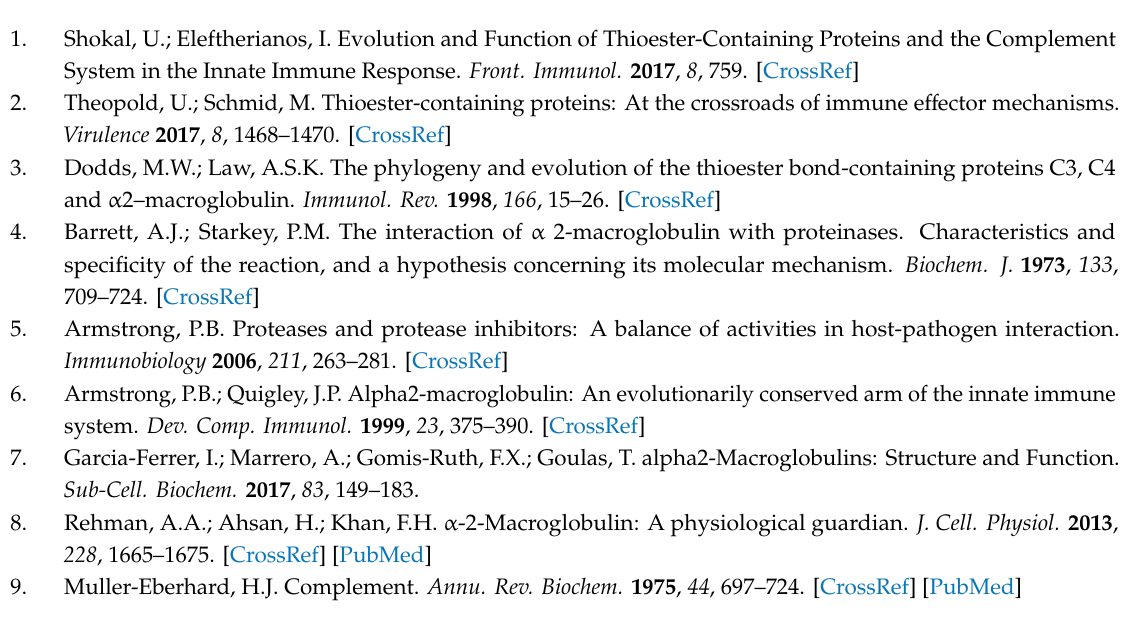
Figure S1: Alignment file of TEP protein sequences used for the phylogenetic analysis; Figure S2: cDNA sequences of the 11 TEP of Biomphalaria glabrata; Figure S3: ClustalW alignment of BgTEP protein sequences with related sequences from other organisms; Figure S4: ClustalW alignment of each BgTEP protein sequence with corresponding protein sequences predicted from BglaB1 genome assembly; Figure S5: BgTEP2 alternative splicing in snail tissues, Table S1: Table list of primers used to measure gene expression by quantitative PCR; Table S2: Table list of protein sequences used to construct phylogenetic tree; Table S3: Genome organization of BgTEP genes; Table S4: Genome organization of BgTEP2 splice variants; File S1: Supplementary materials